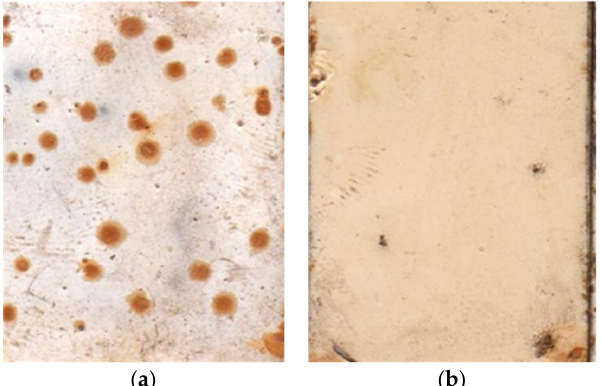
Figure 10. Samples of carbon steel coated with the PC after corrosion tests in the environmental chamber. Ten days. T 60 ◦ C, RH 95%: ( a ) nonmodified steel, ( b ) steel premodified with the BTA solution. Coating thickness – 0.1